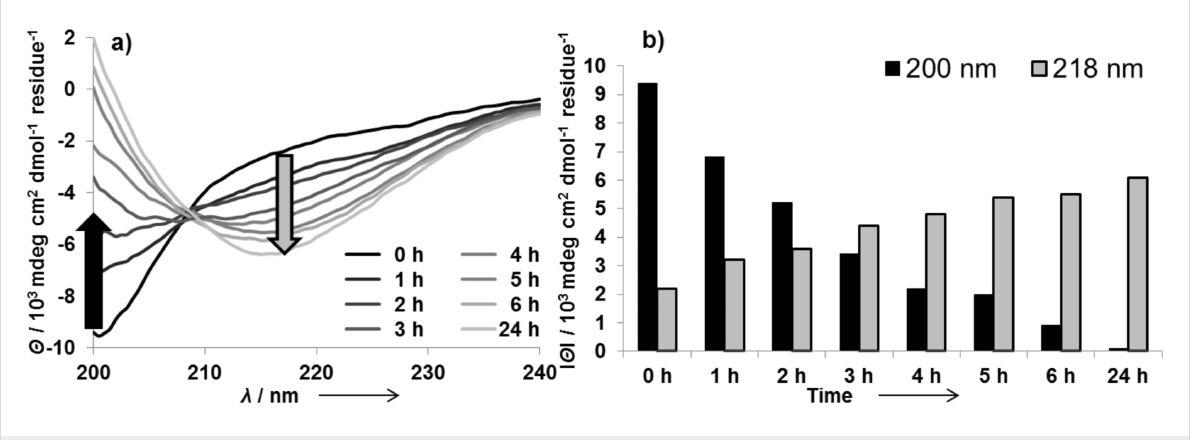
Figure 1: a) Time-dependent CD spectra and b) corresponding CD-minimum plot for random coil (black) and β -sheet (grey) of 15 µM KFM6 in 50 mM Tris/HCl buffer with 10 mM MgCl 2 at pH 7.5 and 24 °C.